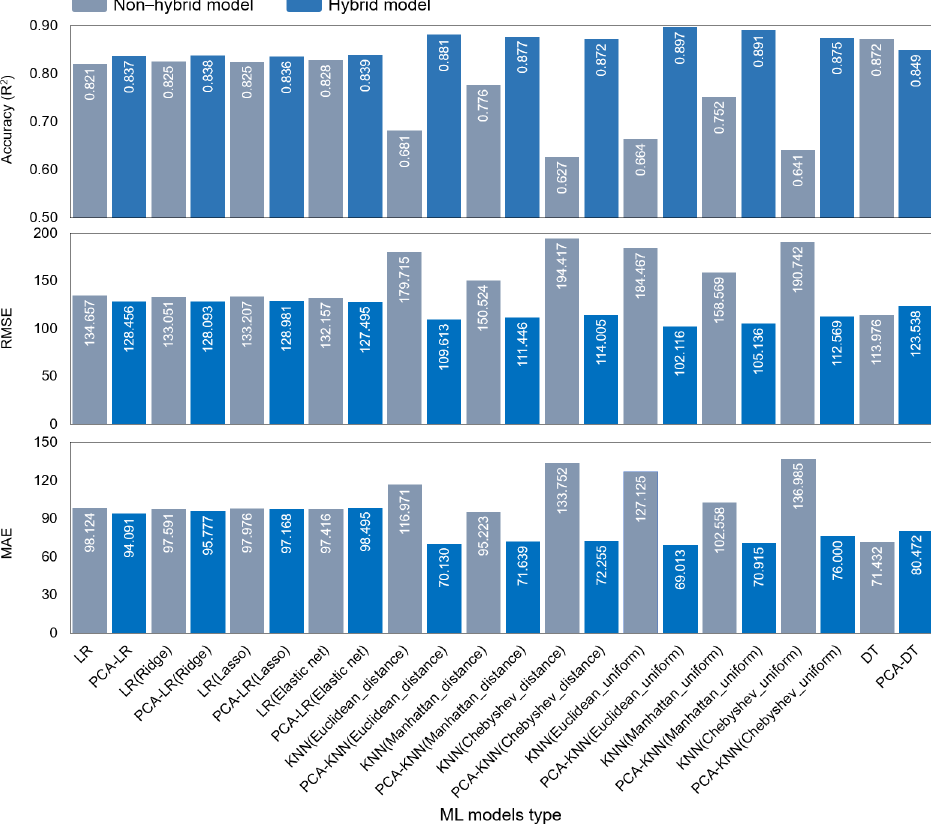
Figure 6. Performance of non-hybrid and hybrid machine-learning models for DWGR prediction.